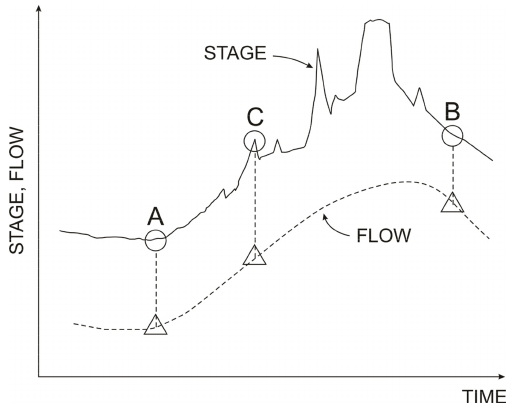
Figure 4. Schematic illustration of typical stage (i.e. water level) and flow (i.e. discharge) variations during the early phase of the spring runoff event. Figure taken from Beltaos (© Crown Copyright, 2012b; published by NRC Research